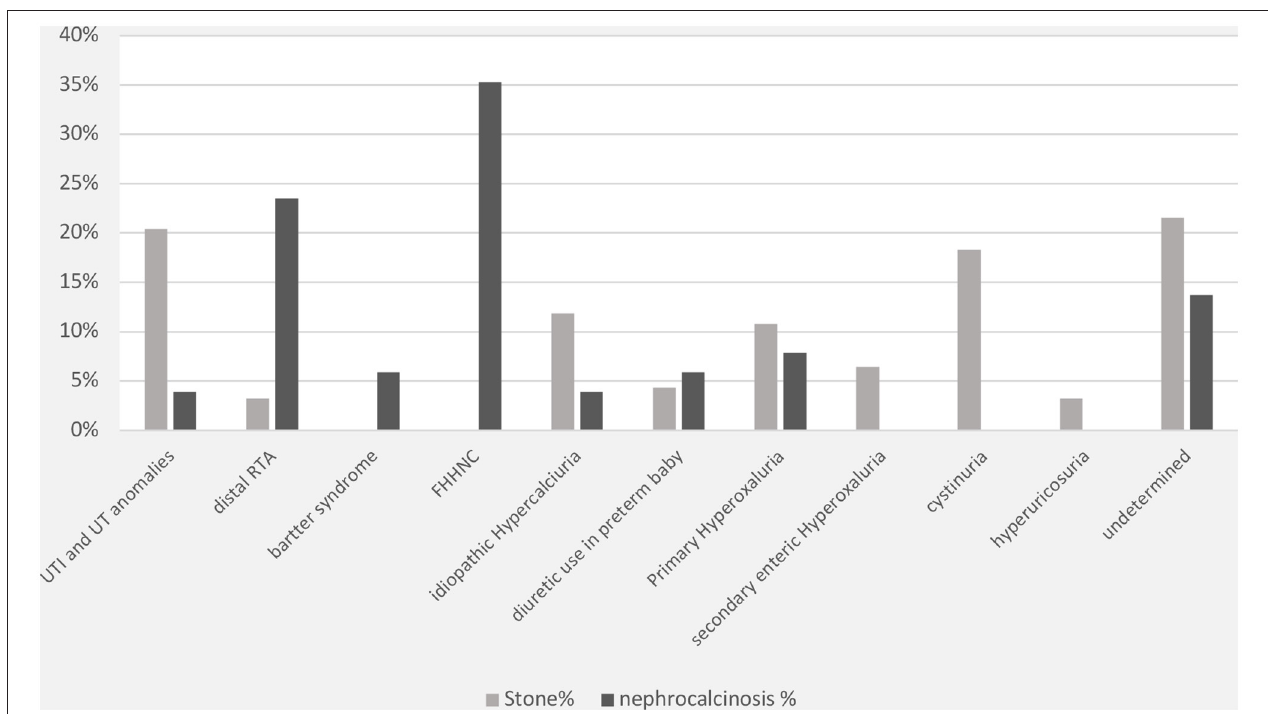
FIGURE 2 | Comorbidities associated with nephrolithiasis/urolithiasis (renal stone) and nephrocalcinosis. FHHNC, familial hypomagnesemia hypercalciuria nephrocalcinosis.